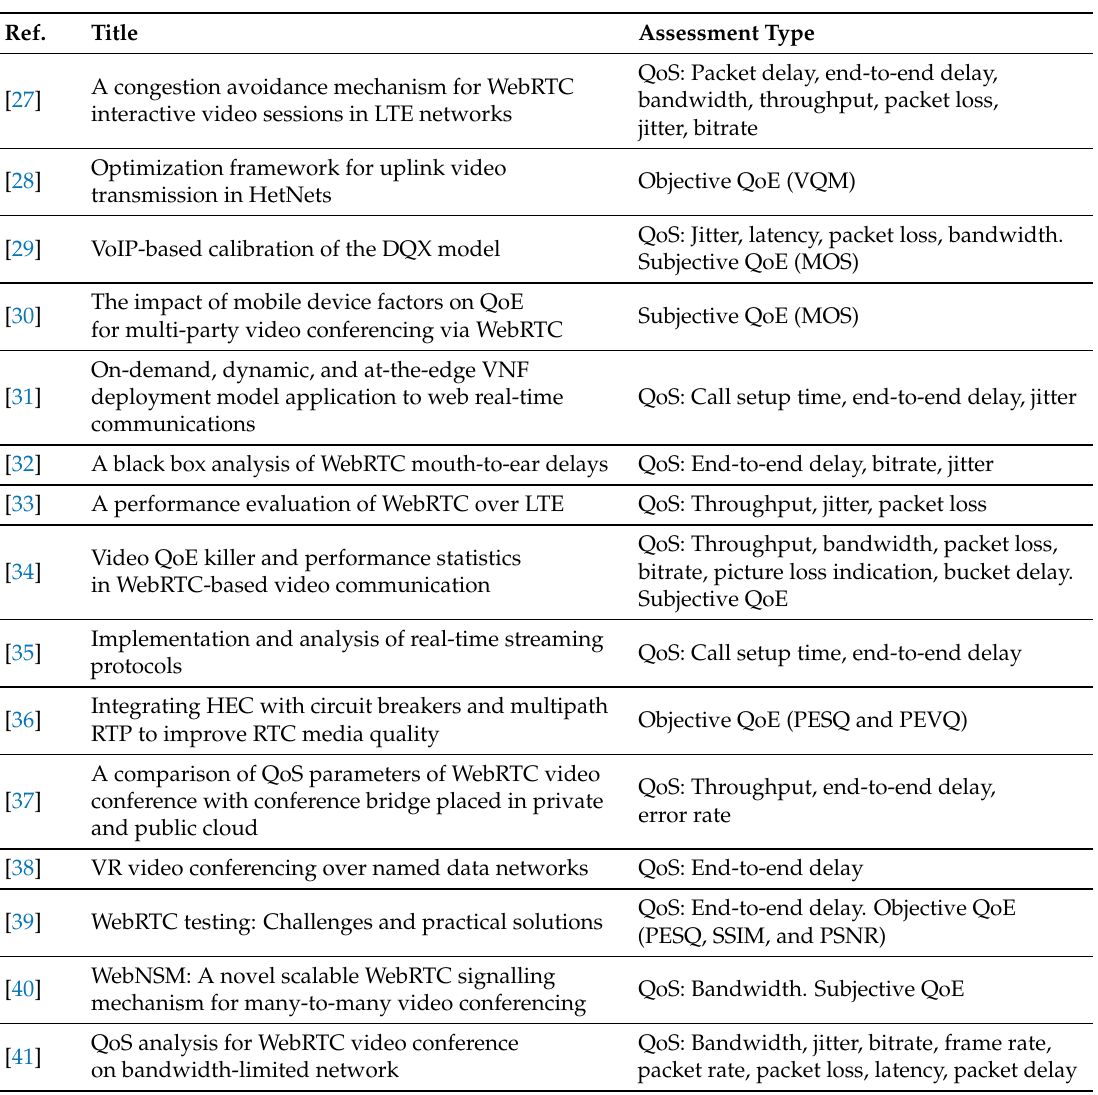
Table 2. Selected papers about WebRTC and Quality of Experience (QoE) between 2014 and 2017 [21].